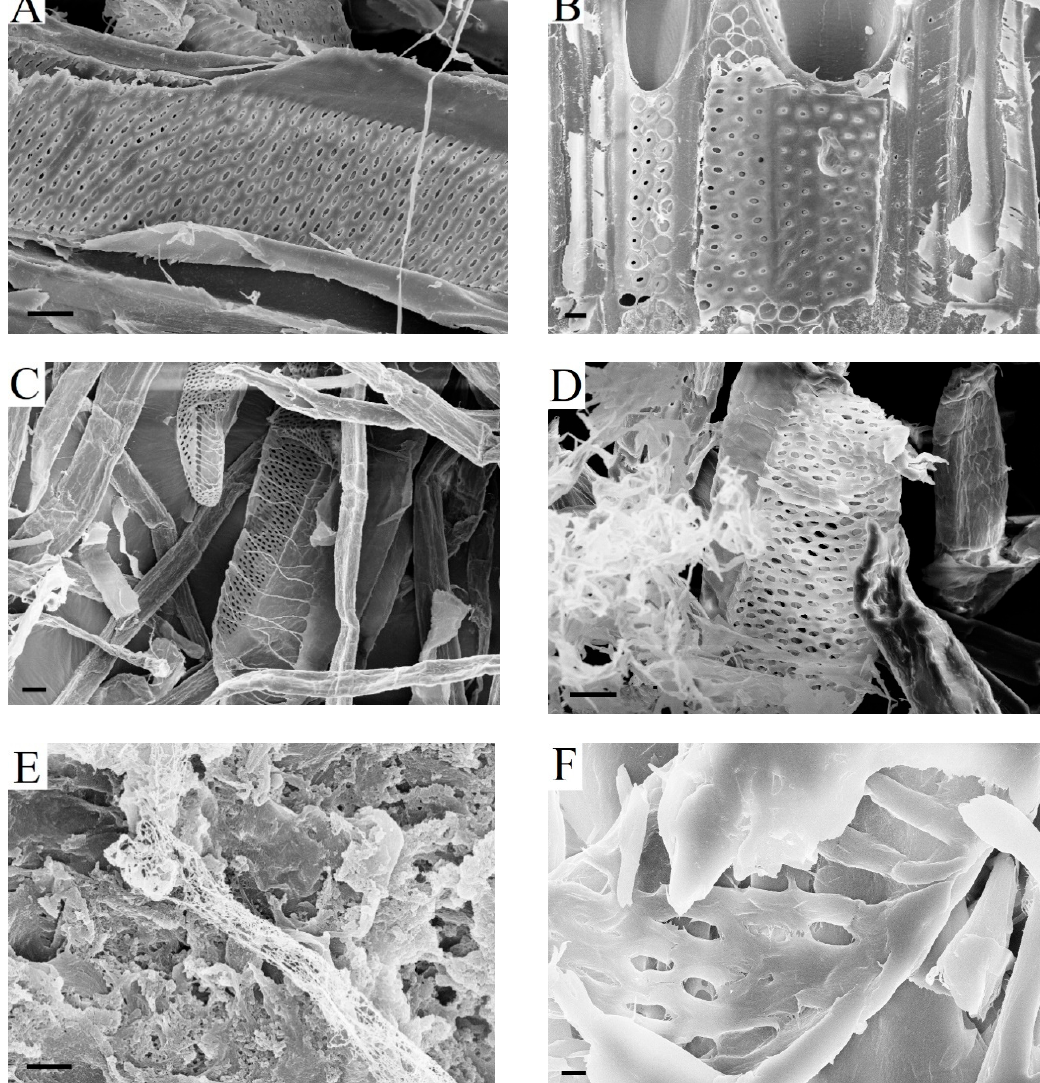
Figure 5. Wood vessels and BHP vessels before and after enzymatic hydrolysis: ( A ) birch wood vessel wall with numerous pits; ( B ) aspen wood vessels with numerous pits of various shapes in the walls; ( C ) vessels fragments of the BHP with numerous pits; ( D ) vessel fragment of BHP after 3 h of enzymatic hydrolysis; ( E ) vessel fragment of the BHP after 8 h of enzymatic hydrolysis; and, ( F ) residue of the vessel wall of BHP after 48 h of enzymatic hydrolysis. Bars: ( A , B , D , E )—10 µ m, ( C , F )—1 µ m.